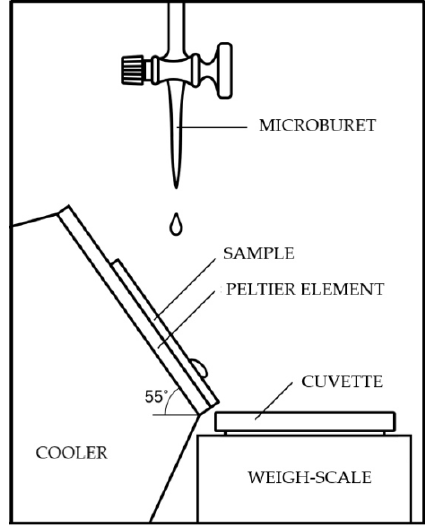
Figure 2. Schematic illustration of the facility for measuring icing speed.